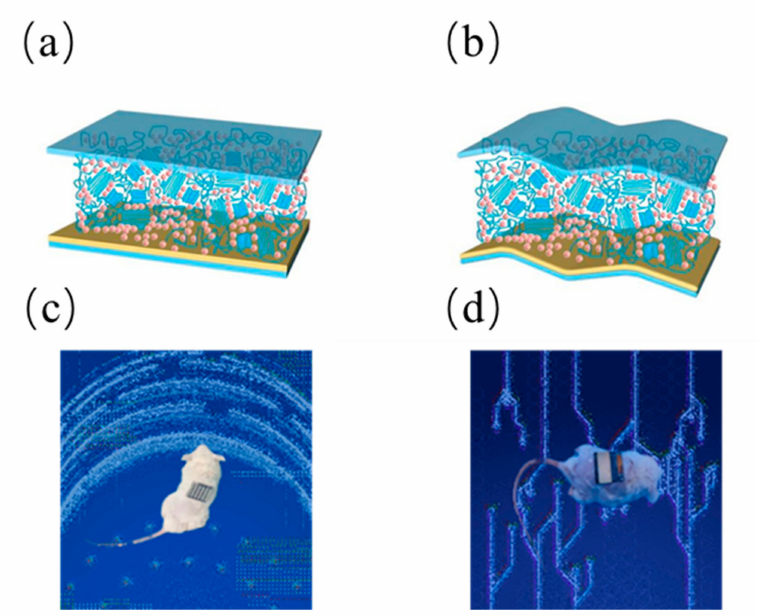
Figure 3. ( a ) Schematic diagram of rigid device morphology ( b ) Schematic diagram of flexible device morphology ( c ) 0.04 cm 2 device on animal photo ( d ) 1.25cm 2 device on animal